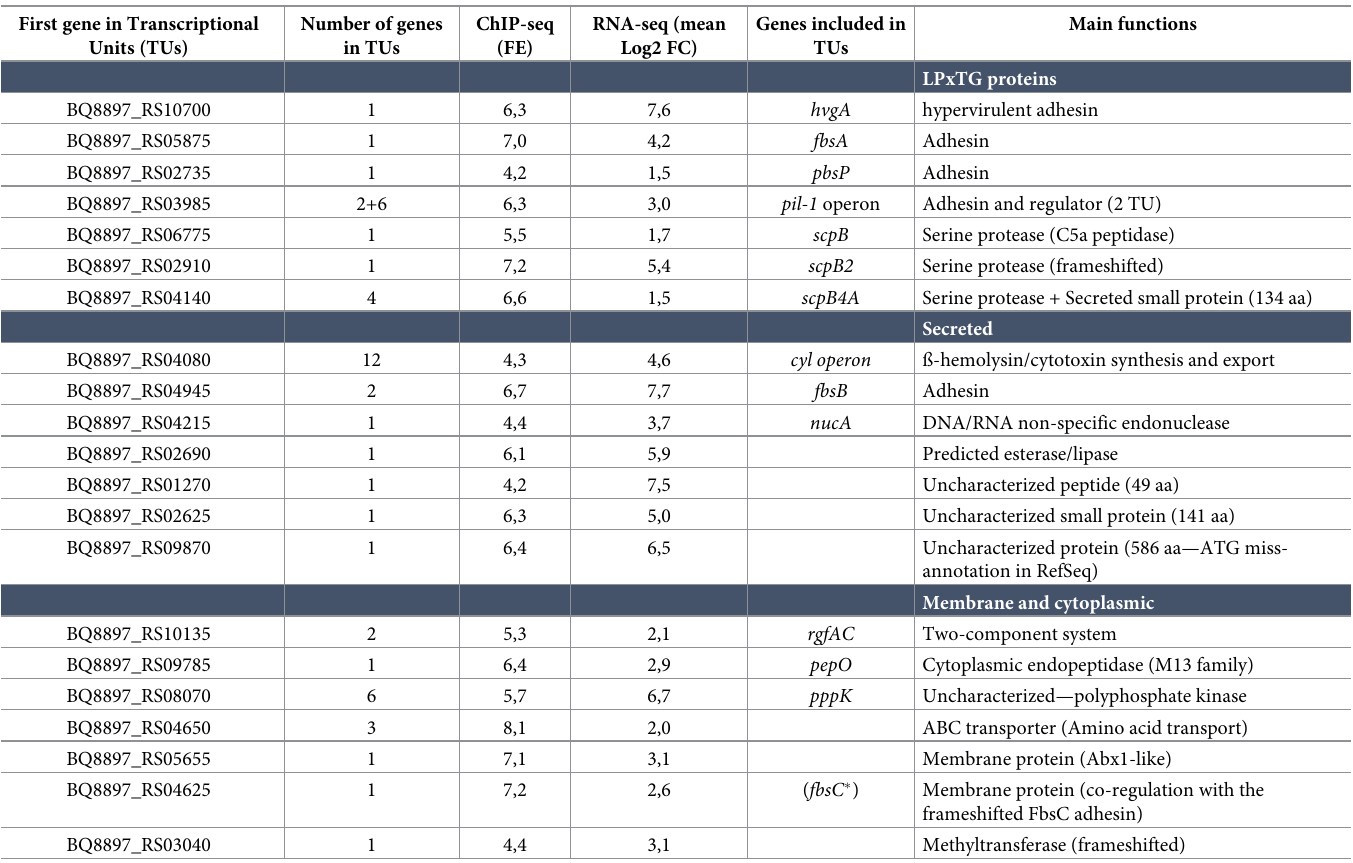
Table 1. The CovR direct regulon in